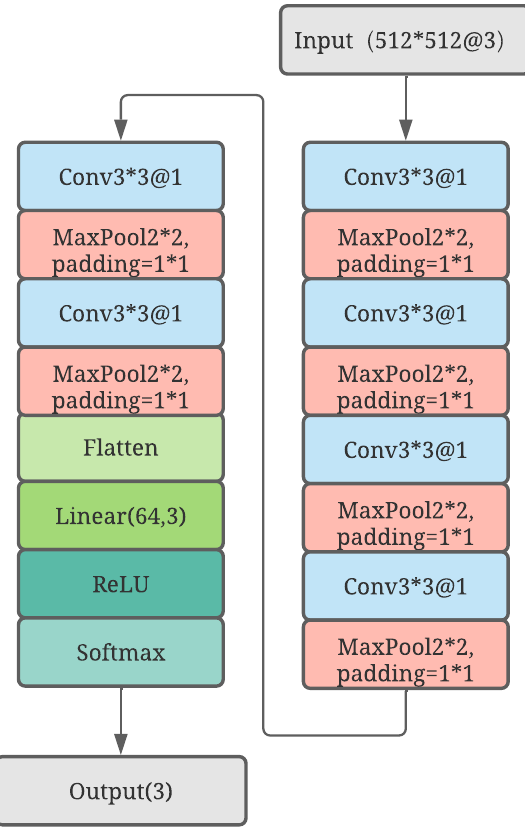
Figure 6. Details of the gate